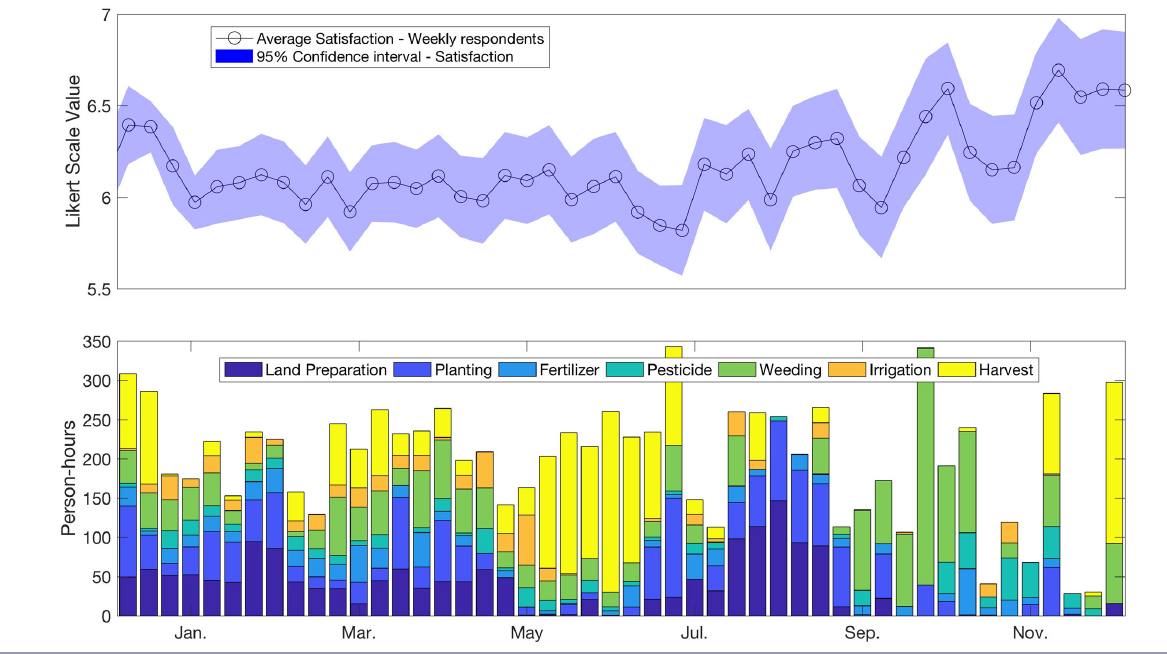
Fig. 2 . Upper panel shows average reported satisfaction with life from respondents selected to respond weekly to subjective well-being (SWB) task (n = 264 initially; n = 118 continued respondents after week 40). Lower panel shows average person-hours per household invested in agricultural labor from respondents selected to respond weekly to labor task (n = 129 initially; n = 15 continued respondents after week